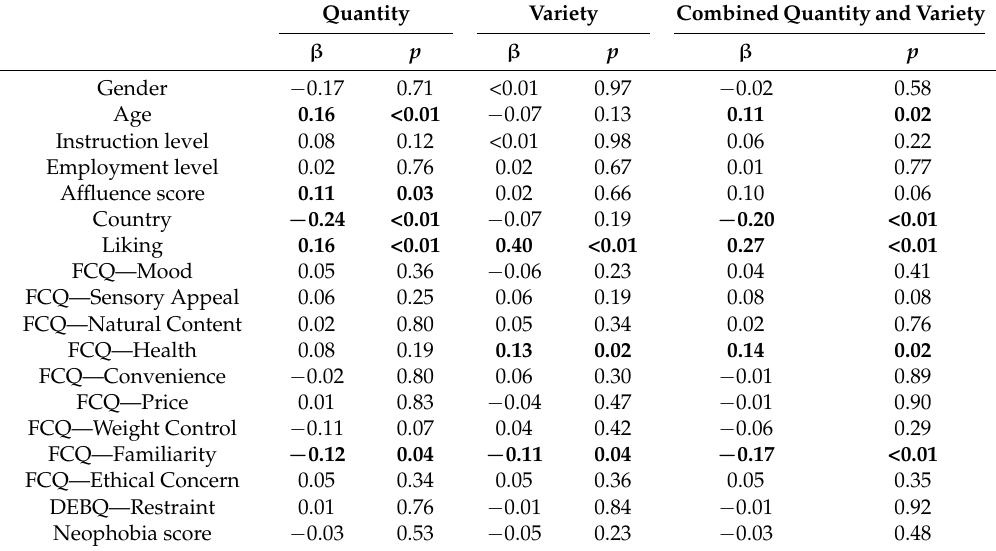
Table 3. Results of the regression analyses using demographic characteristics and all liking and attitude variables to predict quantity, variety and combined quantity and variety scores in all participants ( n = 497). Quantity Variety Combined Quantity and Variety